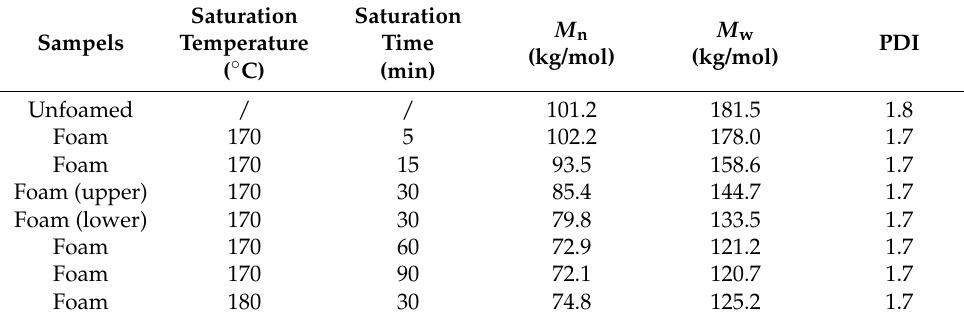
Table 2. The RMW and PDI of unfoamed and foamed samples.